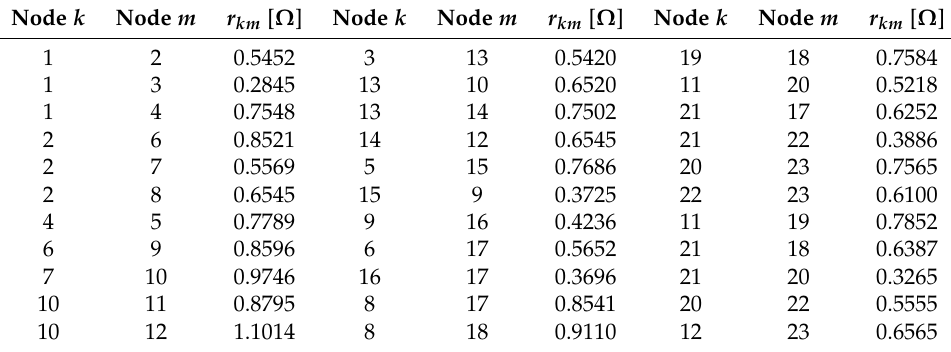
Table 3. Existing and proposed connections in the 23-nodes test feeder.